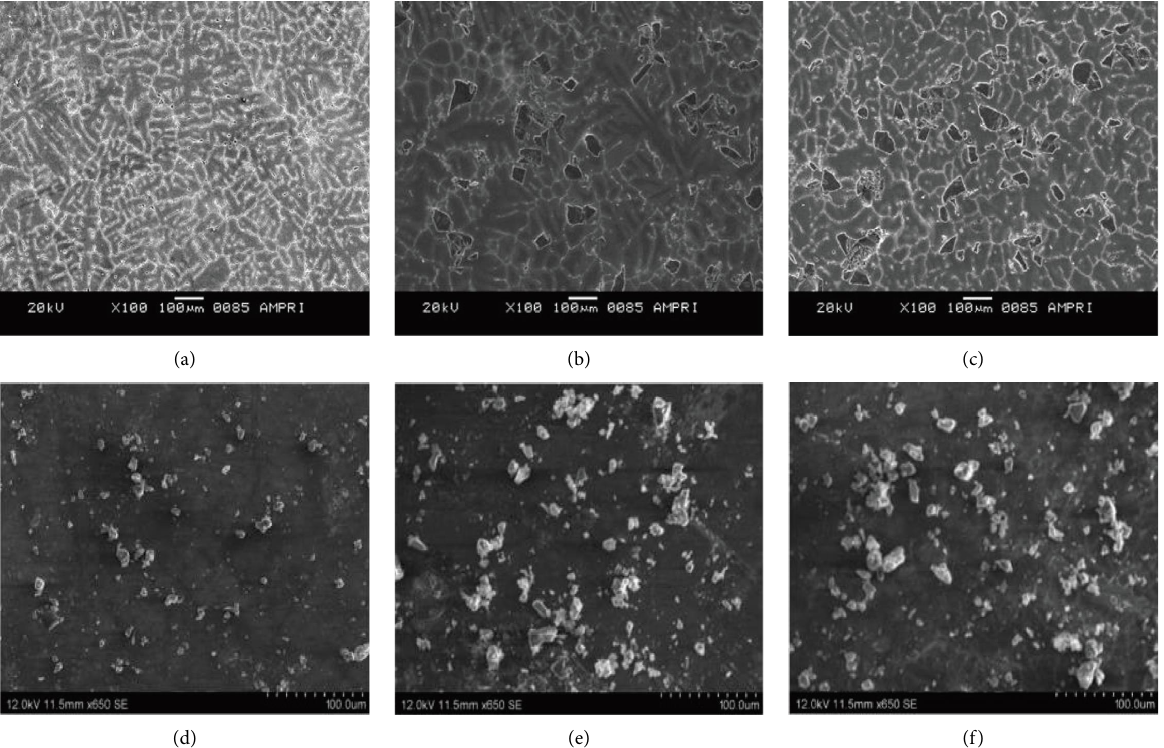
Figure 3: SEM image of (a) Al 7075 [84], (b) Al 7075/10wt.% of SiC (20–40 μ m) [84], (c) Al 7075/15 wt.% of SiC (20–40 μ m) [84], (d)